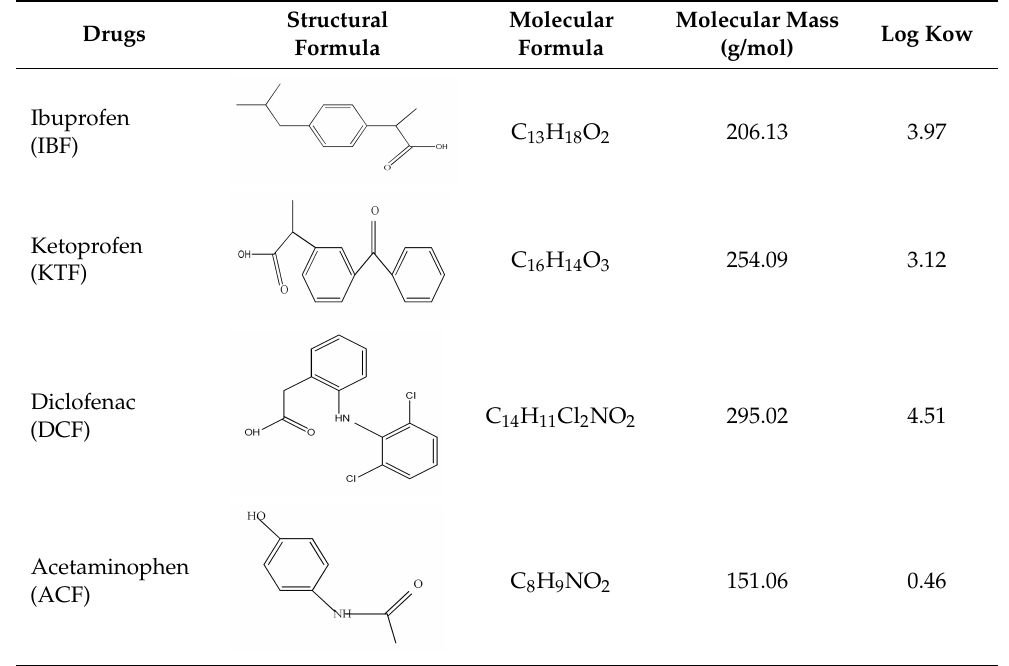
Table 3. Drugs’ physicochemical